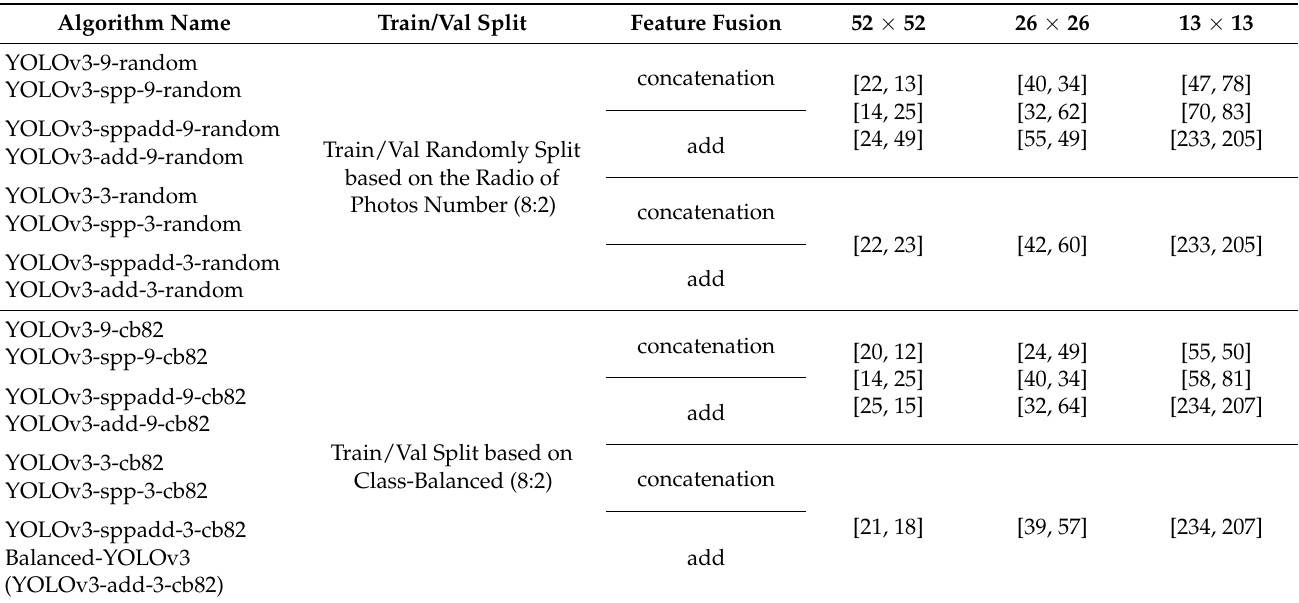
Table 3. Algorithm naming statistics for the two Train/Val split datasets and proposed